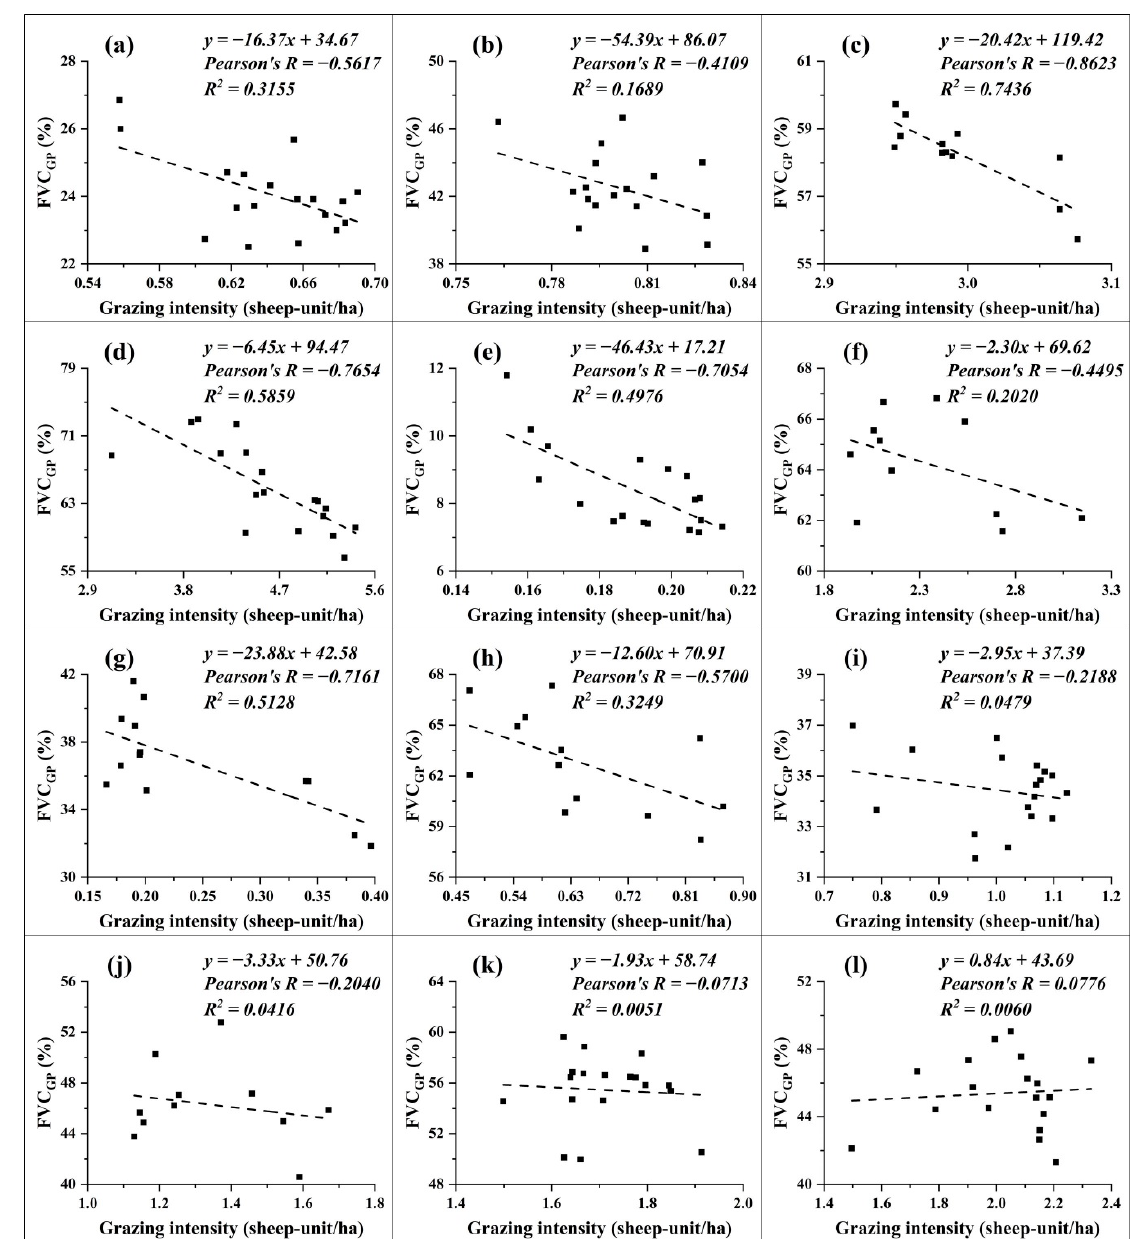
Figure 8. Correlation results between FVC GP and grazing intensity at provincial ( a , b ) and county levels ( c – l ): ( a ) Tibet, ( b ) Qinghai, ( c ) Menyuan, ( d ) Zhouqu, ( e ) Rutog, ( f ) Dege, ( g ) Qumarlêb, ( h ) Chindu, ( i ) Basu, ( j ) Kangding, ( k ) Seni, and ( l ) Damxung.